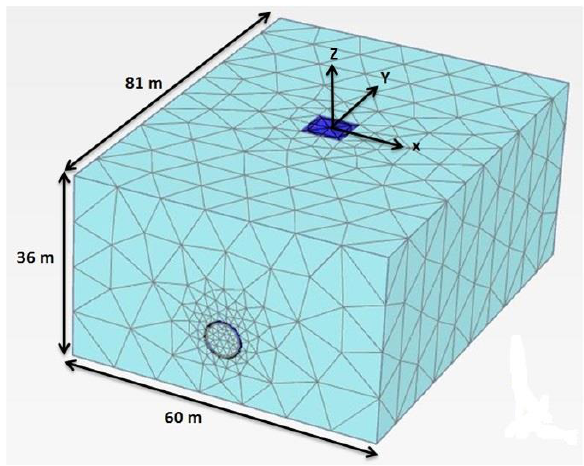
Fig. 1 3D finite element meshes, dimensions of problem and axis location used in the analysis